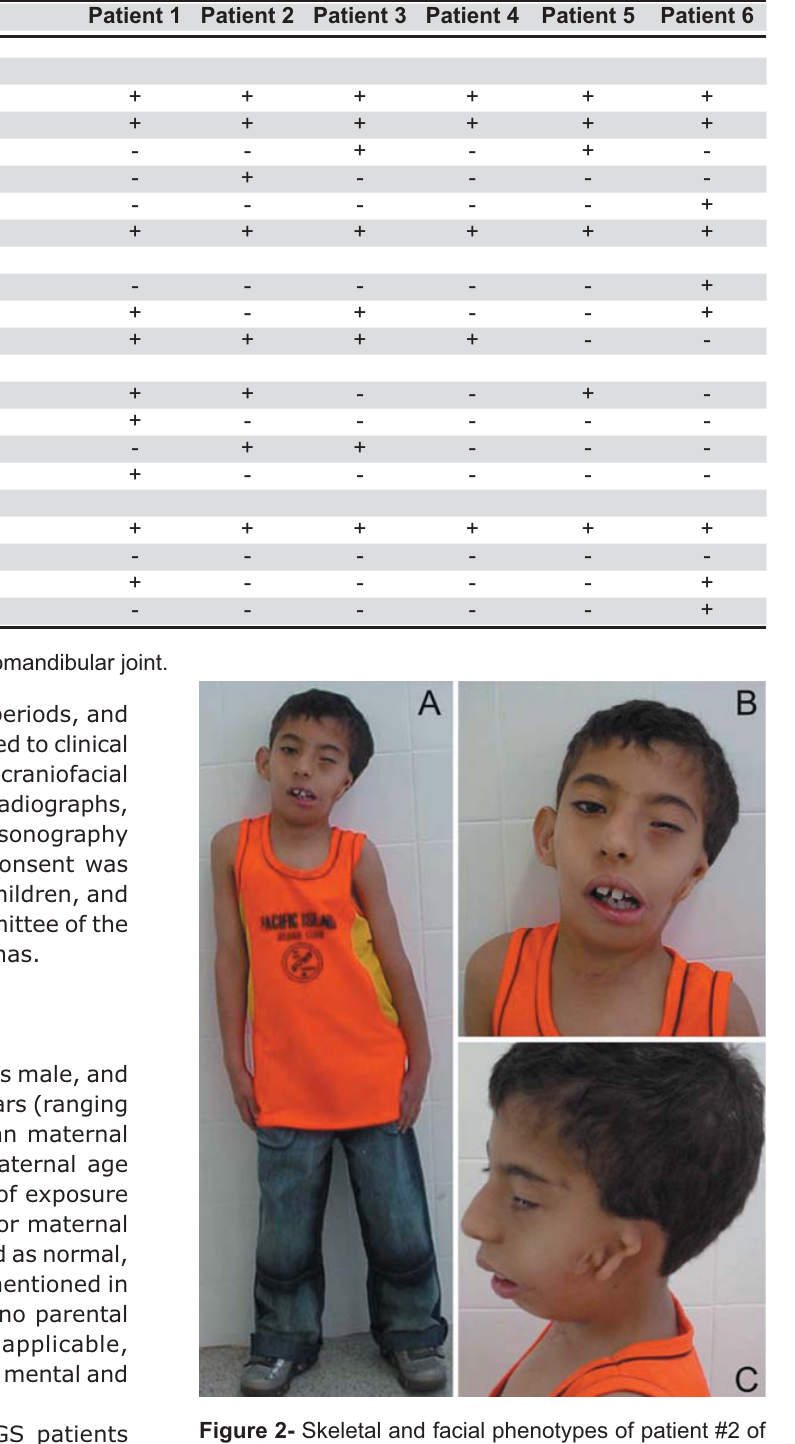
Figure 1- (cid:2)(cid:3)(cid:4)(cid:5)(cid:2)(cid:6)(cid:7)(cid:8)(cid:9)(cid:2)(cid:10)(cid:11)(cid:8)(cid:9)(cid:8)(cid:10)(cid:7)(cid:11)(cid:2)(cid:12)(cid:9)(cid:13)(cid:8)(cid:9)(cid:14)(cid:15)(cid:2)(cid:16)(cid:17)(cid:2)(cid:18)(cid:4)(cid:5)(cid:2)(cid:19)(cid:2)(cid:20)(cid:7)(cid:18)(cid:8)(cid:5)(cid:9)(cid:18)(cid:15)(cid:2)(cid:21)(cid:8)(cid:18)(cid:4)(cid:2)(cid:22)(cid:23)